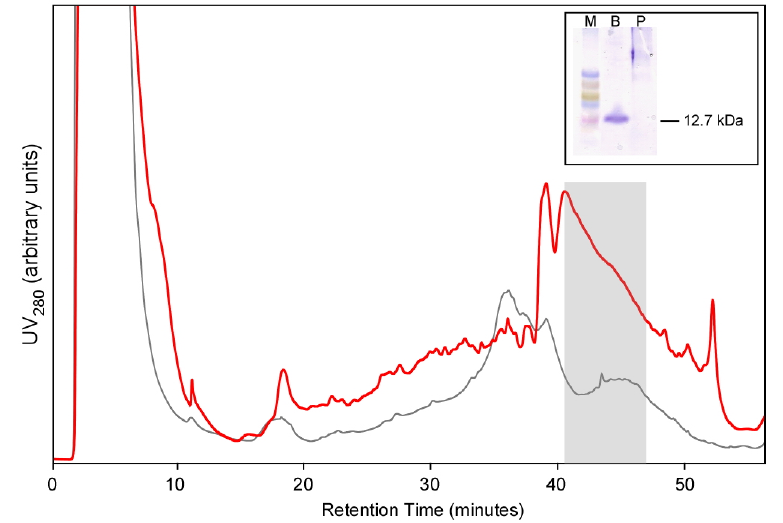
Figure 3. Chromatogram from HPLC purification of Pichia pastoris expressed BcSnod1 (red) and empty vector control (gray). BcSnod1 was present in fractions 41–47, indicated by the gray box. In the inset, SDS-PAGE of the concentrated combined fractions for BcSnod1 (B) and Pichia only control (P) are shown next to a molecular weight marker